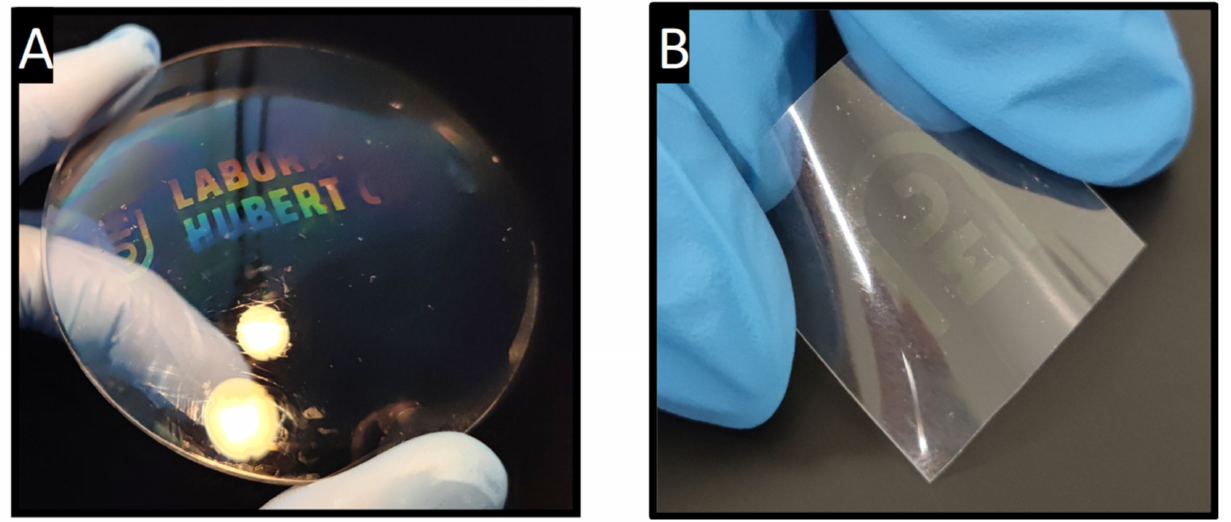
Figure 5. Examples of structuring on unconventional substrates: ( A ) ZrO 2 multiscale pattern on a convex glass optical lens and ( B ) ZrO 2 pattern on flexible